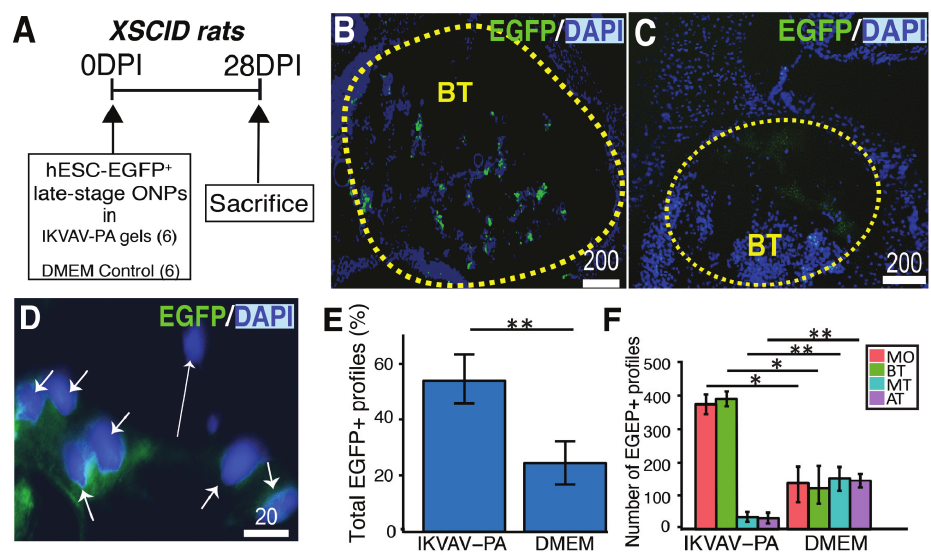
Fig 5. IKVAV-PAgels enhance survivalof transplanted EGFP + in the X-SCID rat cochlea. (A) : An experimental paradigm. DPI: days post injection. (B) : Anti-EGFP antibodylabelingof EGFP + cells in the basal turn of the XSCID cochlea.BT: basal turn. Scalebar = 200 μ m. (C) : Controlexperiment showingDMEM only injectioninto the cochlea.Scalebar = 200 μ m. (D) : Example high-power imageof DAPI and EGFP profilesat cellularlevelusedfor subsequent quantification. Scalebar = 20 μ m. (E) : The percentageof EGFP + profilesper sectioninjectedwith IKVAV-PA gelsin and with DMEM (n = 6 for each condition). (F) : Comparisonof EGFP + profilesin eachturn and the modiolusinjectedwith IKVAV-PA gels in and with DMEM (n = 6 for eachcondition). Abbreviation: MO: modiolus; BT: basalturn; MT: mid turn; and AT: apicalturn. * p < 0.05, ** p < 0.01, and *** p <